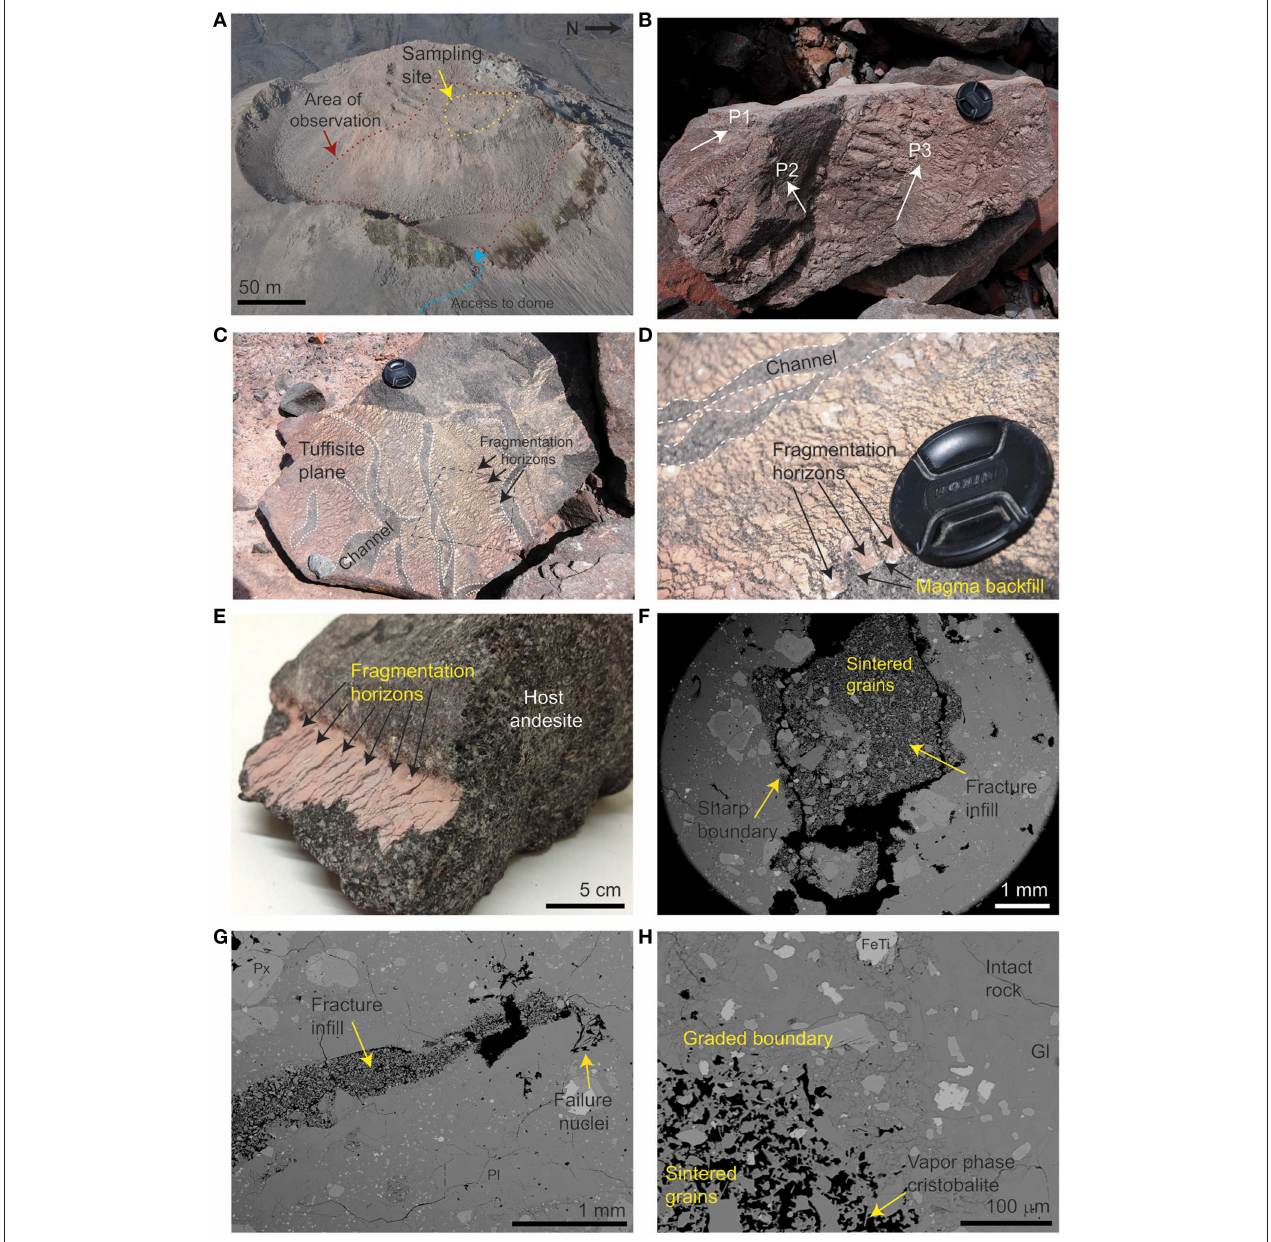
FIGURE 4 | Lava dome samples in detail. (A) Photograph of the Volcán de Colima lava dome on 27th May 2011, a month before the cessation of activity which allowed access to the dome on 20th March 2012, when ∼ 1/3 of the lava dome surface was surveyed (red dashed area) and samples were collected (yellow dashed area). (B) 40cm long block in situ on the lava dome with tuffisite on the surface and propagating through the rock in at least three planes (P1, P2, P3; marked with arrows) that cross-cut one another. (C) A surface exposure along the plane of the tuffisite, which shows sub-parallel lenses of sintered fragmental material interpreted as fragmentation horizons (marked by black arrows). The tuffisite plane is scoured or excavated by channels (white dashed lines) that host no fragmental material, which are deemed to be outgassing pathways. Dashed box shows area in; (D) A zoomed image of the fracture and channel patterns with magma backfill, i.e., the residual structure of the viscous flow of the magma into the fractures between the sintered pyroclastic lenses that make up the fragmentation horizons. (E) A tuffisite vein propagating inside a porphyritic Volcán de Colima andesite, again showing sub-parallel fragmentation horizons on the oxidized tuffisite surface. (F) BSE image of a tuffisite, here the fracture filled with fragmental material has a sharp contact to the host lava, the fragmental material is rounded to sub-angular and relatively poorly sorted and the tuffisite shows variably sintered zones (denser vs. more porous). (G) BSE image of tuffisite in a fracture widening (to the left) from its nucleation point (the failure nuclei) with angular particles caught ripping from the fragmenting host lava, which is otherwise relatively dense. Crystals of plagioclase (Pl) and pyroxene (Px) dominate the phenocrysts assemblage (H) BSE image of gradational fracture damage at the boundary of the tuffisite and host lava, where fragment boundaries become increasingly defined toward the tuffisite. Pyroclastic material in the vein is sintered, as indicated by the sub-rounded morphology dictated by the interstitial glass. The tuffisite vein contains needles of vapor phase deposited cristobalite. Phenocrysts of iron-titanium oxides (FeTi) are smaller than plagioclase and pyroxene phenocrysts, and interstitial glass (Gl) is hard to distinguish from plagioclase crystals but is present throughout host rock and tuffisite vein.